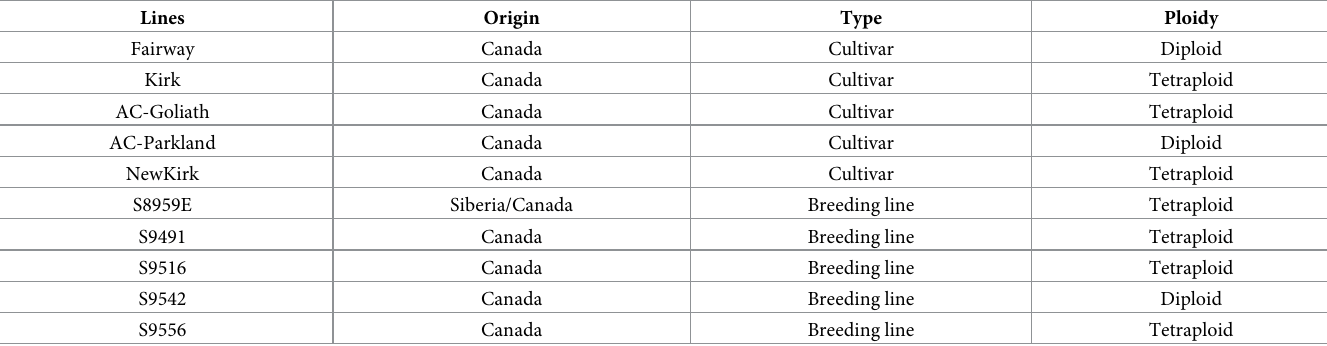
Table 1. List of the 10 crested wheatgrass ( A . cristatum ) lines used in the study.